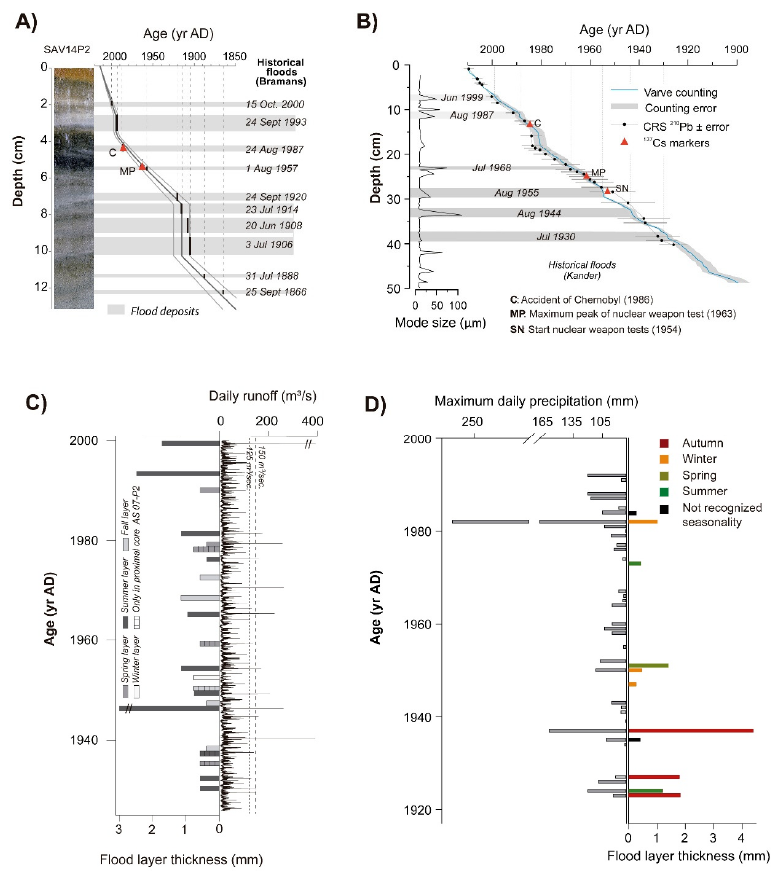
Figure 8. Examples of flood record calibration against different instrumental and historical dataset types. ( A ) Lake Savine (France) non-varved flood record (age-depth model from 137 Cs and 210 Pb radiometric dating techniques) vs. historical floods from Lake Bramans (modified from Sabatier et al., 2017 [118]); ( B ) Lake Oeschinen (Switzerland) varved flood record (age–depth model built by varve counting and 137 Cs and 210 Pb dating) with documented floods from Kander river (modified from Amann et al., 2015 [68]); ( C ) Lake Ammersee (Germany) flood deposit occurrence and thickness vs. daily runoff from river Ammer (modified from Czymzik et al., 2013 [55]); ( D ) Lake Montcortès (Spain) flood layers occurrence and thickness vs. annual maximum daily precipitation from a nearby meteorological station (modified from Corella et al., 2014 [38]).